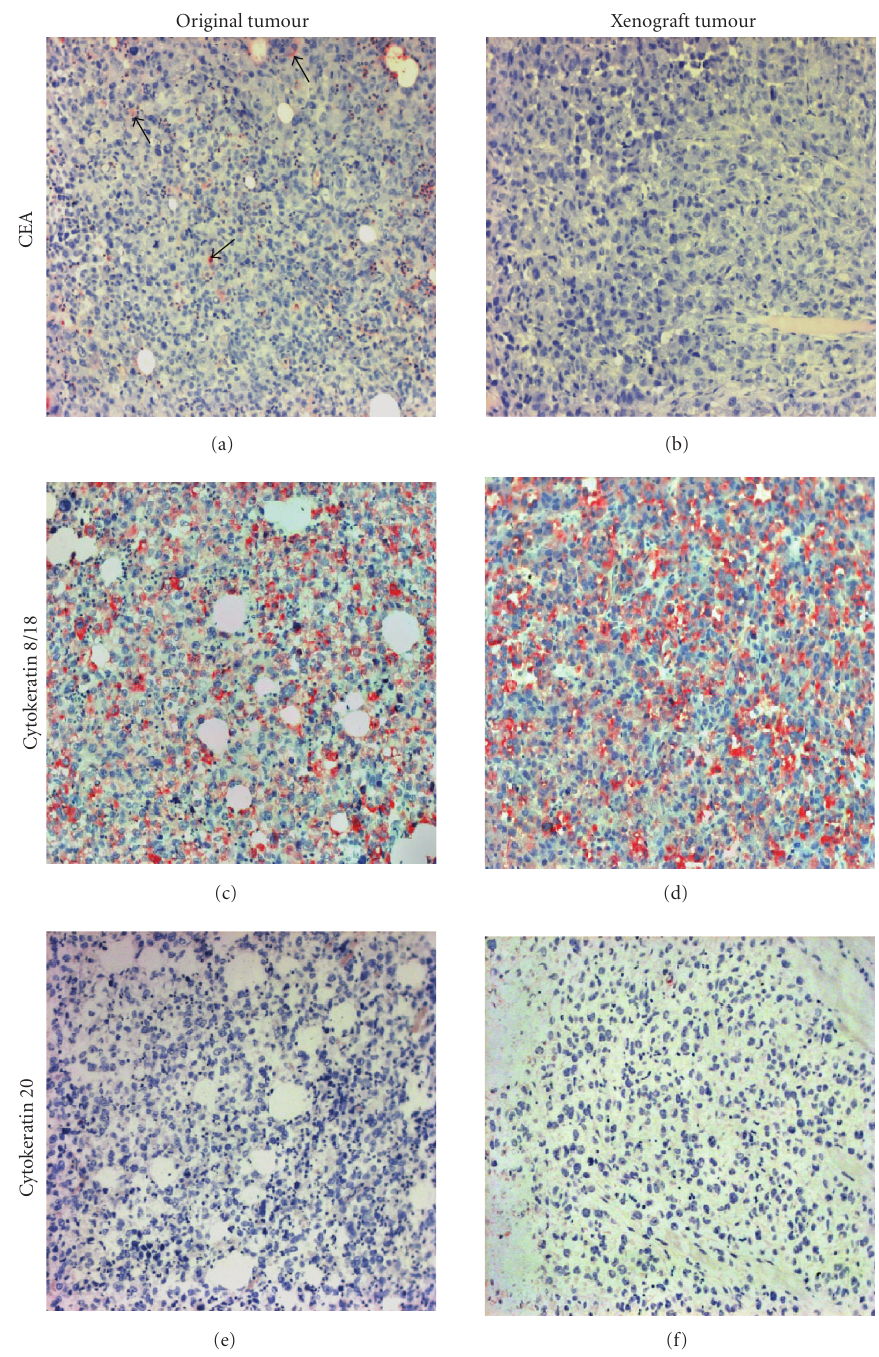
Figure 4: Immunohistochemical analysis of original and corresponding xenograft tumour AKH23. Sections were stained with (a), (b) antibodies specific for CEA, (c), (d) cytokeratin 8/18, and (e), (f) cytokeratin 20. (a) Arrows indicate few stained cells in the original tumour AKH23 reacting with the CEA-specific antibody. Magnification: